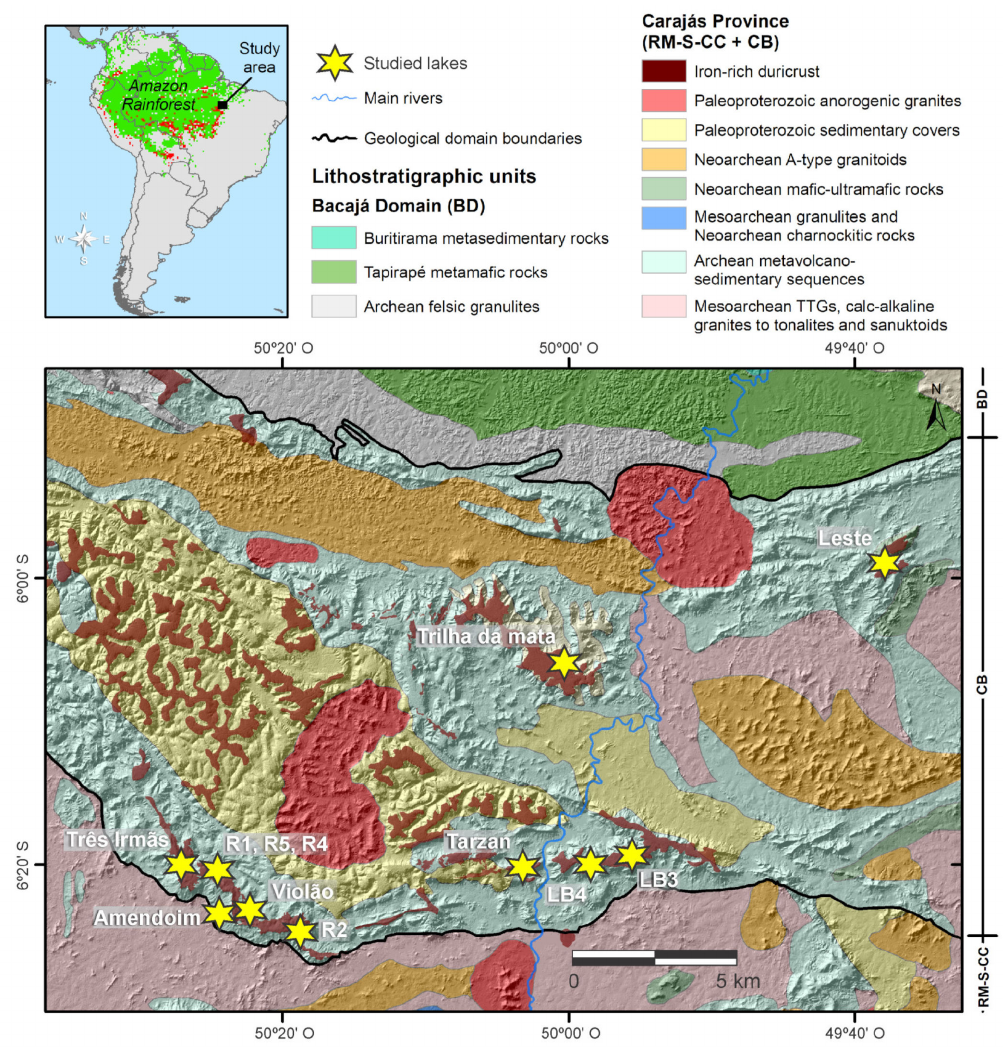
Figure 1. Upper map with study area in the context of South America and Amazon Rainforest (green area: forest cover, red areas: deforestation). Lower map with associated legends: geological map showing the main lithological units of the Caraj á s mountain range in the Brazilian Amazon. The studied lakes are located in the lateritic crusts in the Sul (active lakes: Tr ê s Irm ã s, Amendoim, Viol ã o; filled lakes: R1, R2, R4, R5), Norte (filled lake: Trilha da mata), Leste (active lake: lagoa Serra Leste—LSL), Tarzan (active lake: Tarzan) and Boca í na (filled lakes: LB3, LB4) plateaus; modified from [43]. Caraj á s Province (RM + S-CC + CB: Rio Maria + Sapucaia + Cana ã dos Caraj á s domains + Caraj á s